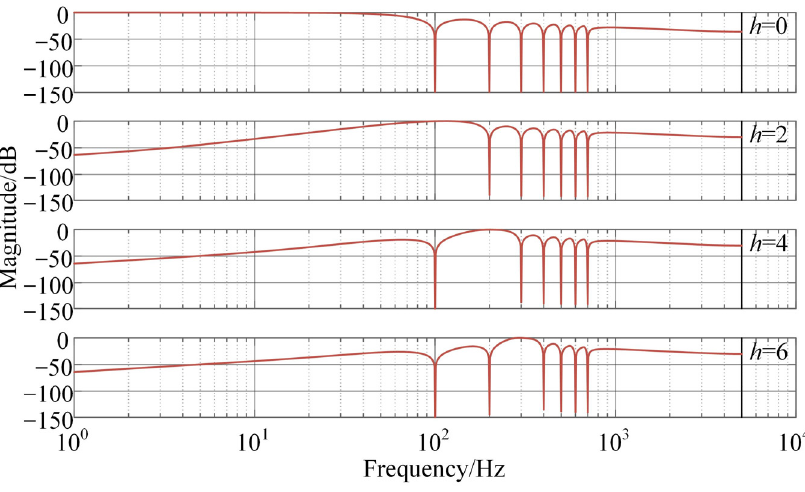
Figure 4. The amplitude–frequency curves of SHEA for different harmonic extractions.